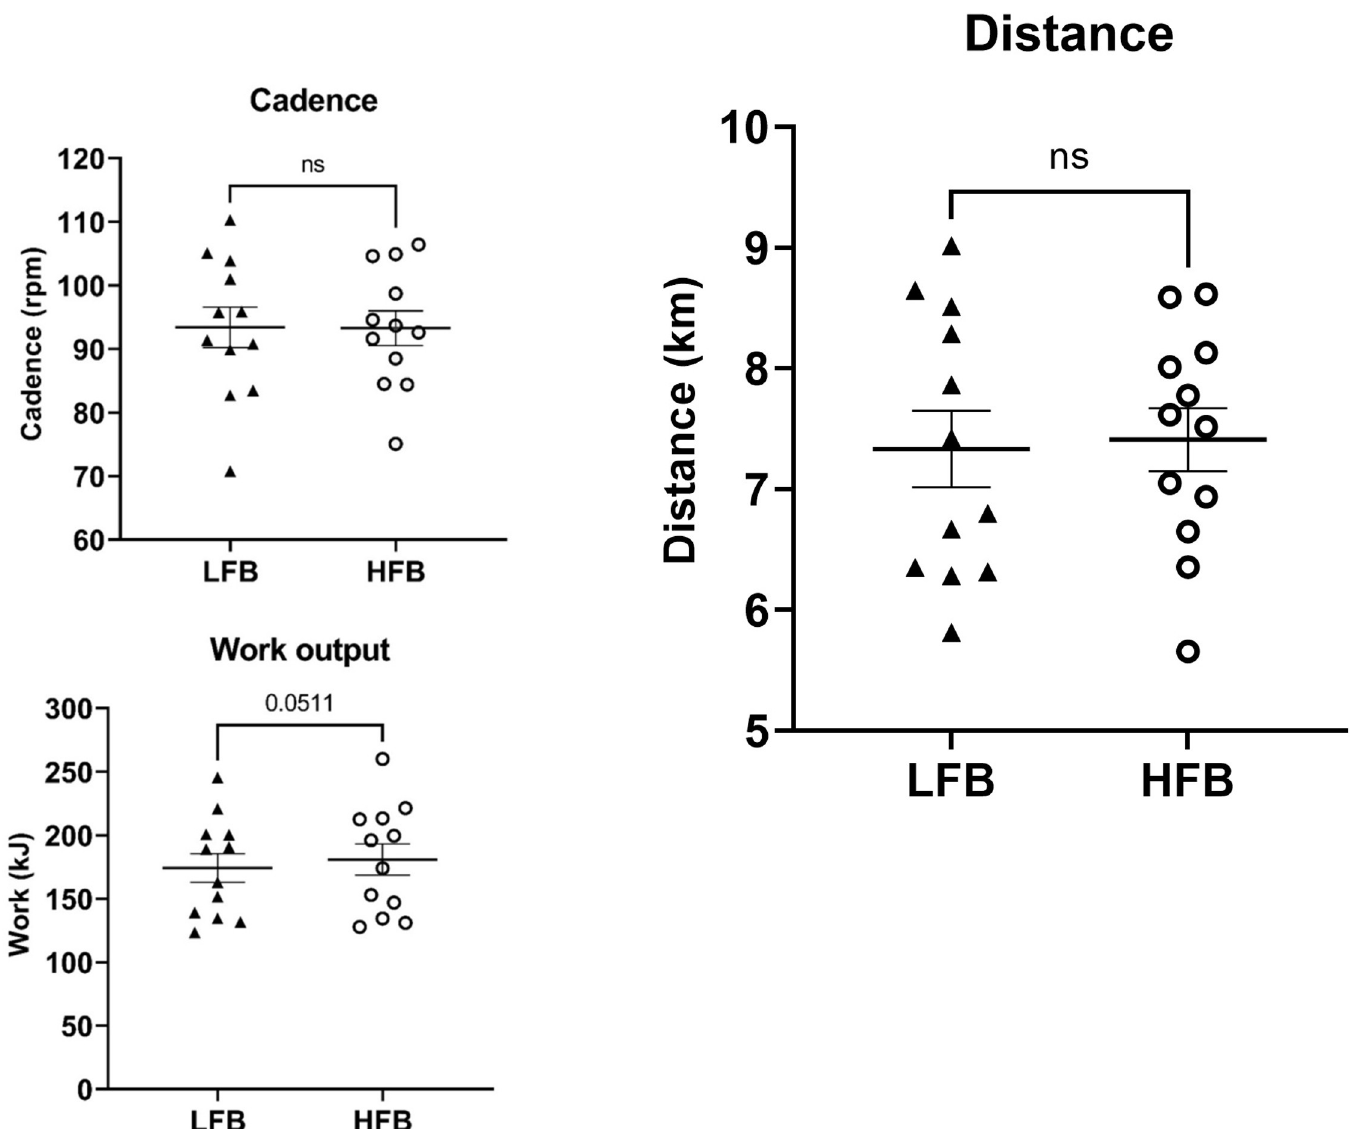
Fig 3. Cycling performance metrics during 15-min TT. (A) Mean cycling cadence (LFB: 93 ± 11 rpm, HFB: 93 ± 9 rpm). (B) Distance completed (LFB: 7.3 ± 0.3 km, HFB: 7.4 ± 0.3 km). (C) Work output (LFB: 174.2 ± 11.3 kJ, HFB: 180.9 ± 12.3 kJ).